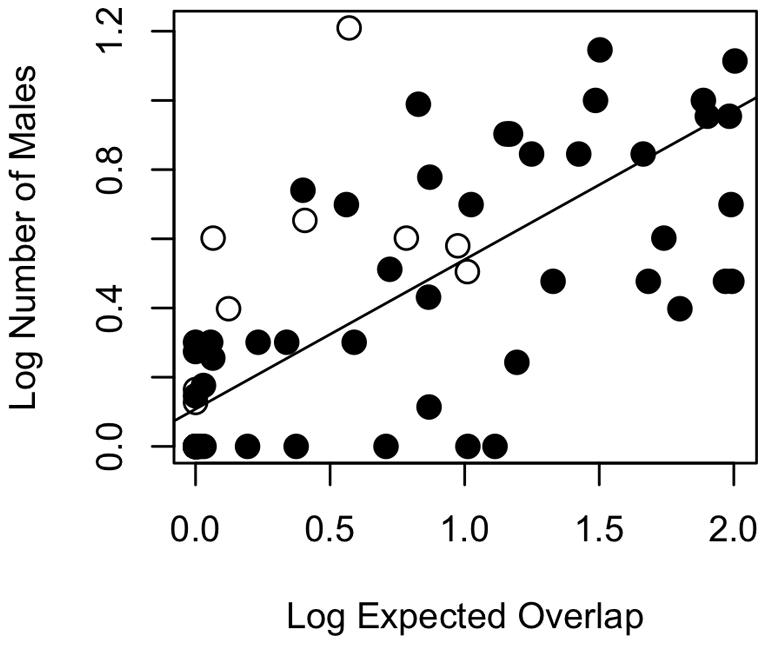
Association between number of males and expected estrous overlap.Data are log10 transformed. The regression slope of 0.432 was obtained as the mean of the posterior probability distribution from regressing the number of males on estrous overlap and controlling for phylogeny (R2 = 0.47, lambda = 0.29). All 10,000 sampled regression coefficients were positive. The intercept of 0.108 was also obtained from the phylogenetic analysis. Haplorhines are represented with black circles and strepsirrhines with open circles.